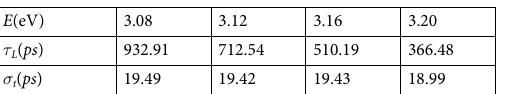
Figure 5. Various lifetimes (solid symbols) of localized carriers in Ag-coated InGaN/GaN quantum wells measured by Okamoto et al. 42 ( a ) for different energy at room temperature and ( b ) for different temperatures. The solid lines are the calculated results with Eqs (16) and (18), independently or jointly, while the dashed lines represent the theoretical curves for overall luminescence lifetime with different parameters ( a ) and the nonradiative lifetime ( b ) respectively. The short dashed line in ( b ) indicates constant radiative